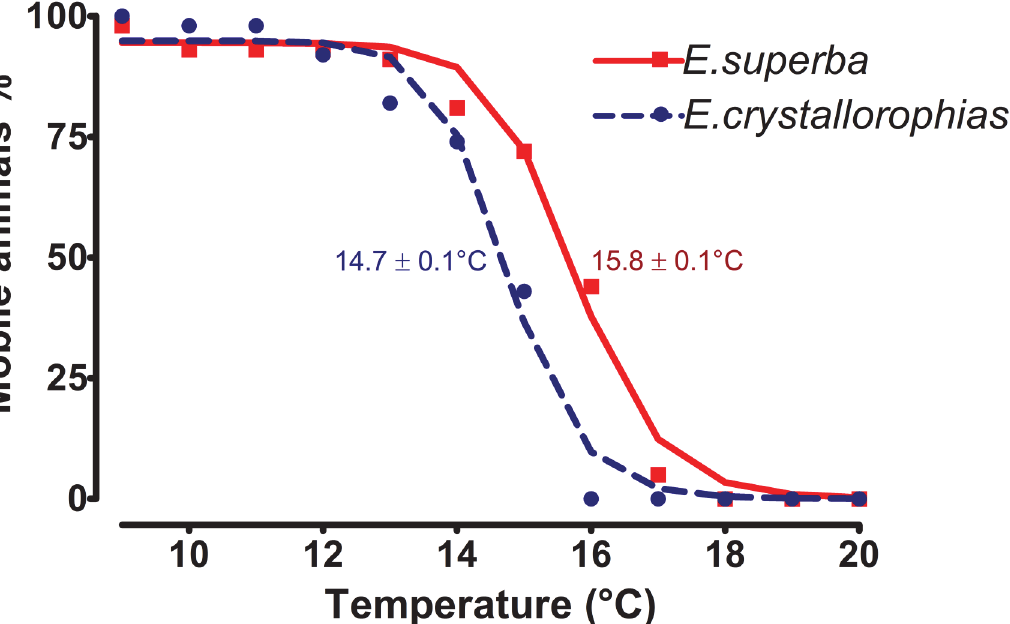
Fig 1. Curves representing the loss of mobility of a population of krill subjected to gradual temperature increase (0.1.min -1 ) ( E . crystallorophias n = 130 blue curve; E . superba n = 43 red curve). CT max is the temperature at which 50% of mobile animals are